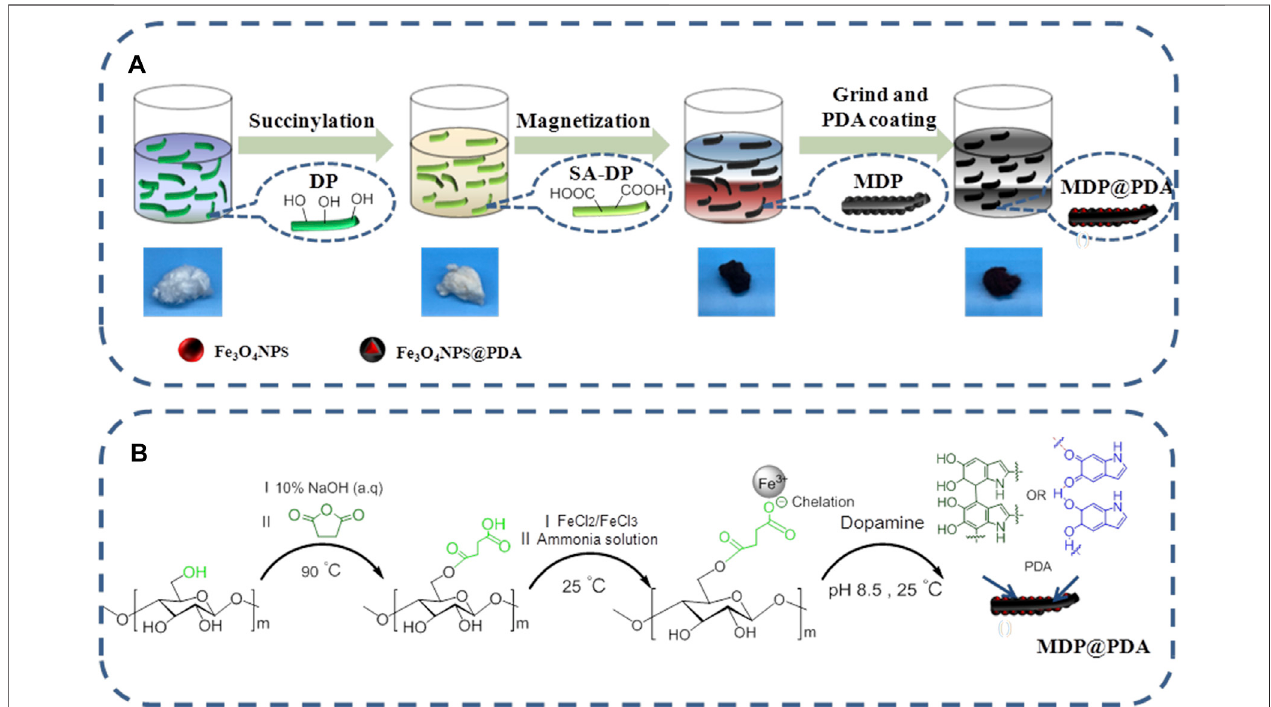
FIGURE 1 | (A) Scheme of synthesis of MDP@PDA fi bers. (B) The synthesis of MDP@PDA.